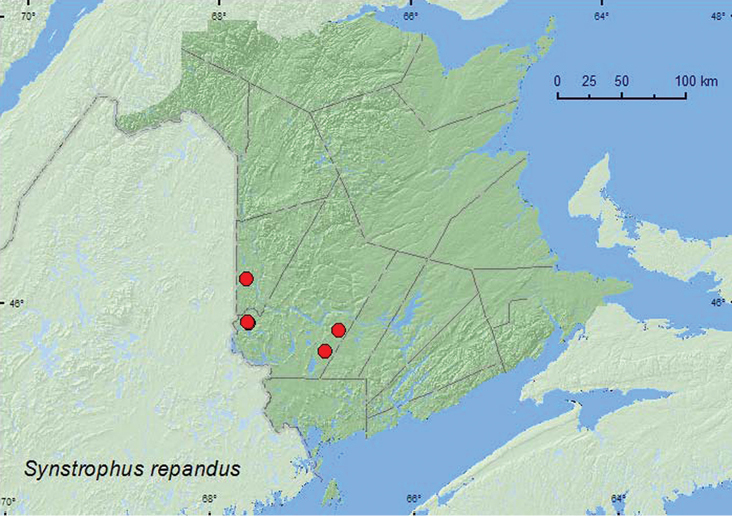
Collection localities in New Brunswick, Canada of Synstrophus repandus.